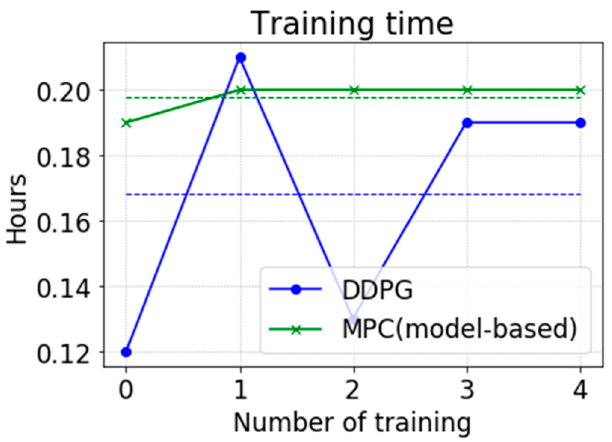
( b ) Figure 13. Learning curves for the performance of the policies trained with different methods: ( a ) maximum-to-minimum interval of each episode in five experimental runs and the average performance and ( b ) maximum-to-minimum interval